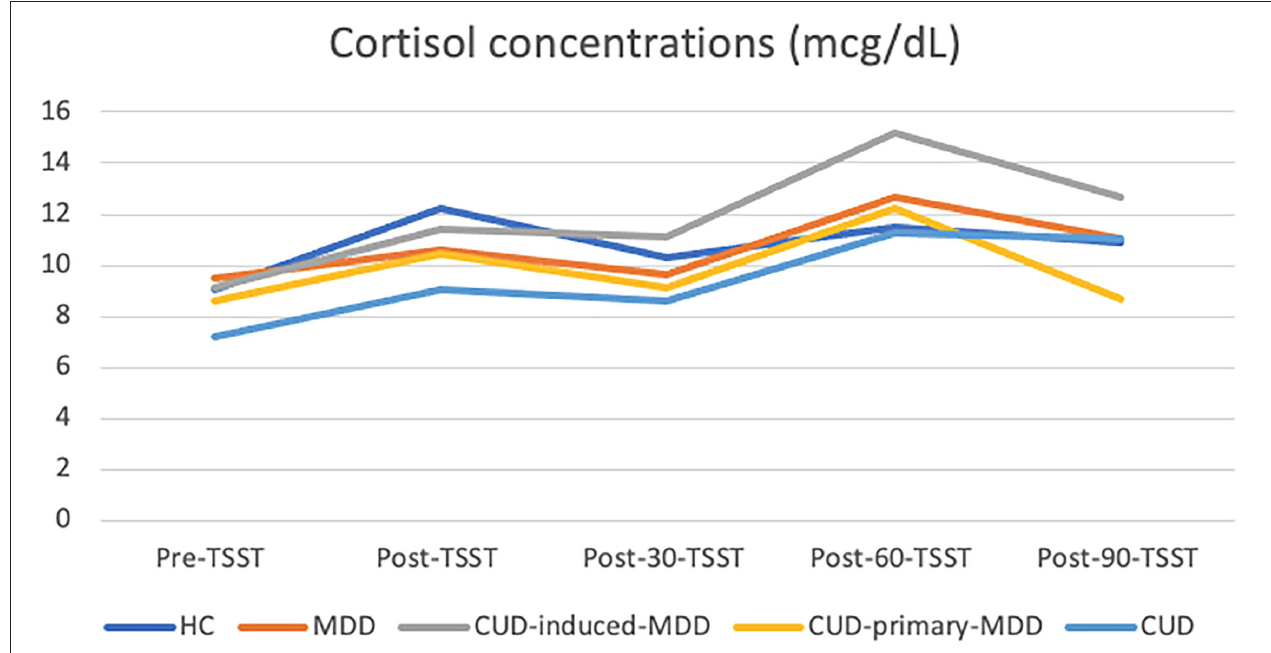
FIGURE 1 | Mean cortisol concentrations during Trier social stress test (TSST). HC, healthy control ( n = 21); MDD, major depression disorder ( n = 6); CUD, cocaine use disorder ( n = 15), CUD-primary-MDD, ( n = 16), CUD-induced-MDD ( n = 9).